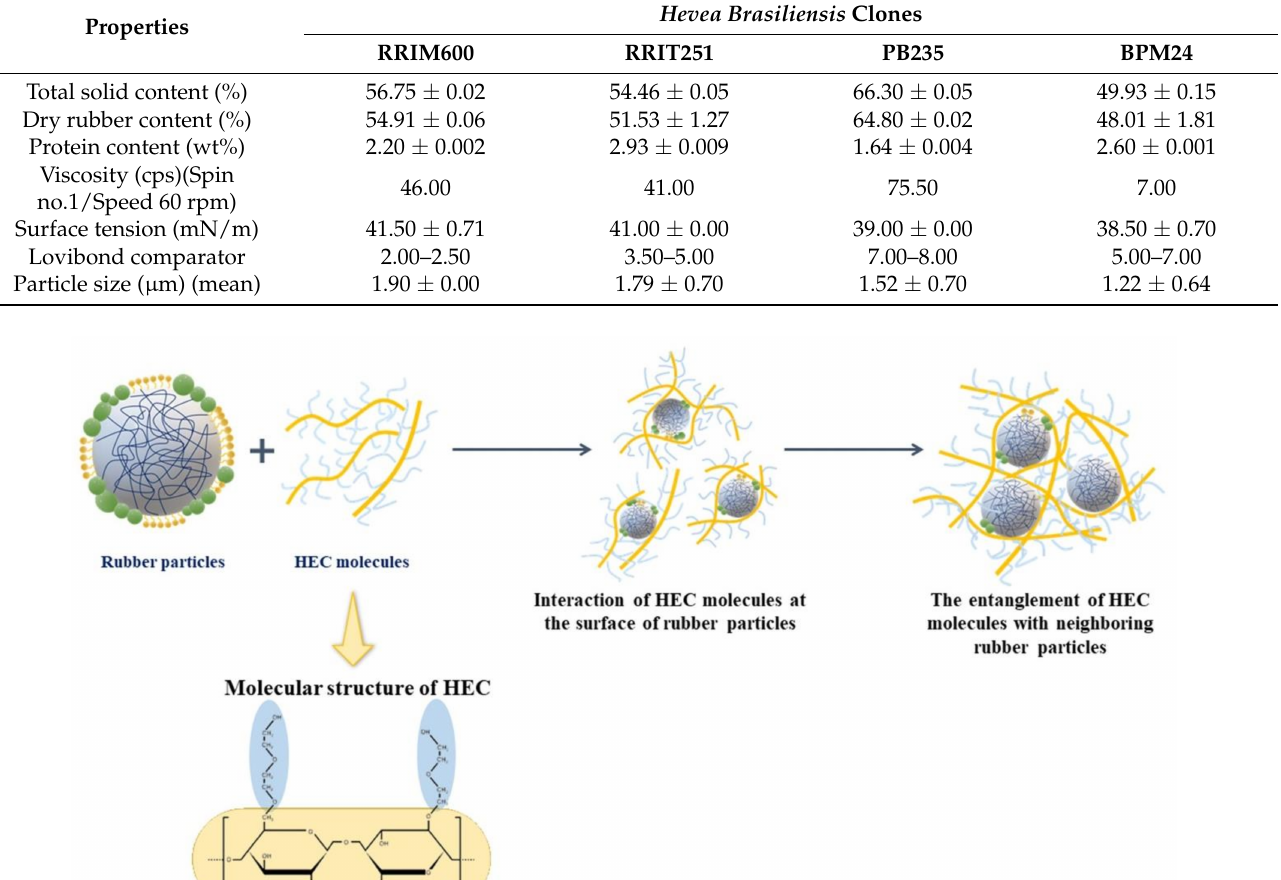
Table 6. TSC, DRC, protein contents, surface tension, viscosity, Lovibond comparator and particles size of the cream concentrated latex from four different Hevea brasiliensis clones.